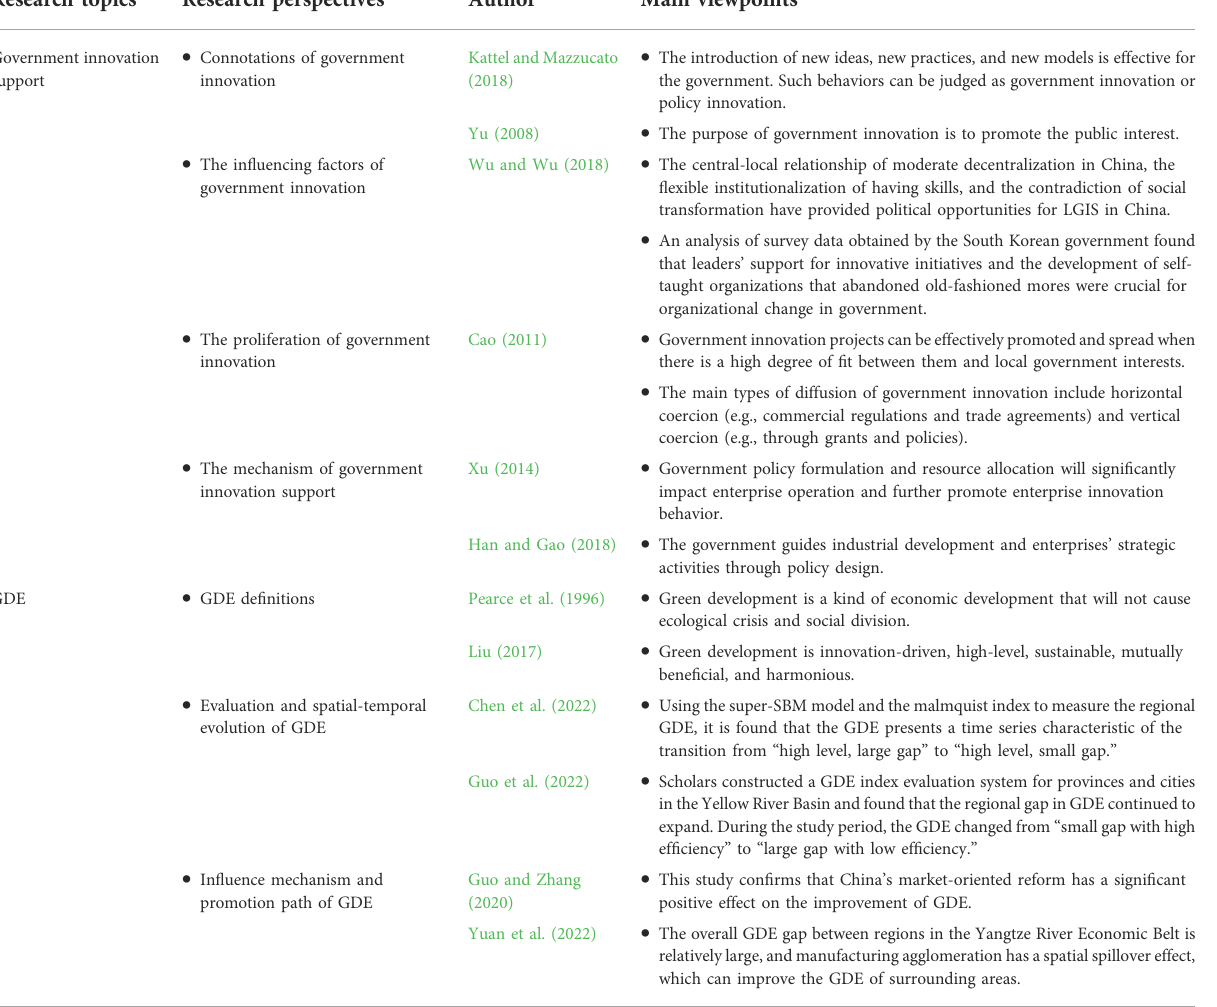
TABLE 1 Previous studies about government innovation support and green development ef fi